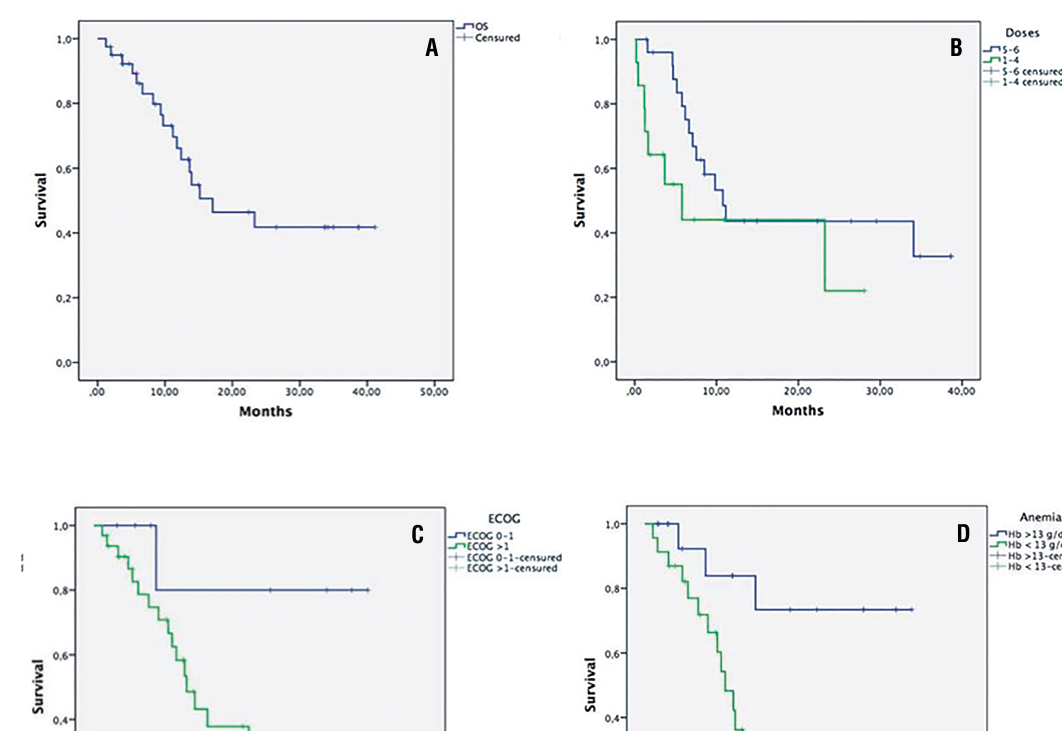
Figure 3 - Kaplan-Meier estimate showing the overall survival in our cohort according to different variables. A. Overall survival. B. Number of doses of 223 Ra. C. ECOG performance status. D. Basal level Hb. E. Metastatic involvement in bone scan. F. Start of 223 Ra